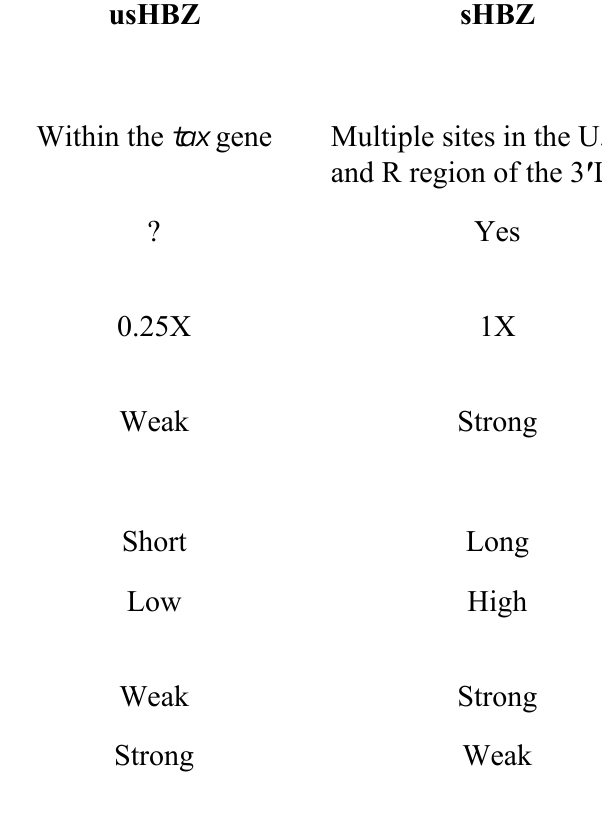
Table 1. Structural and functional differences between the unspliced and spliced